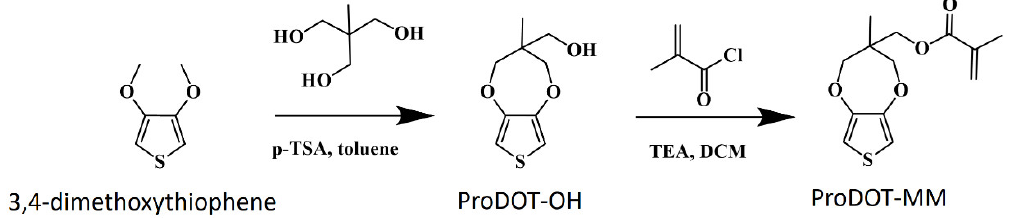
Figure 1. Synthetic route to ProDOT-MM monomer.